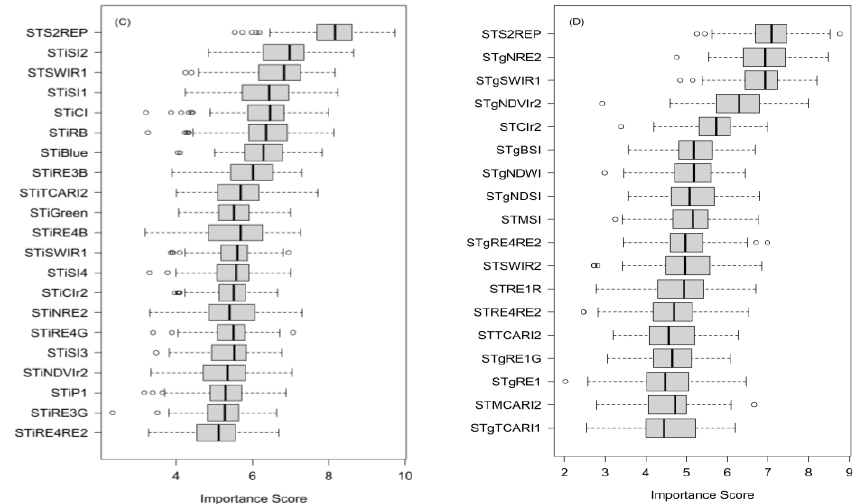
Figure 3. Importance score of Sentinel-2-based spectral indices identified as predictors in ( A ) Sentinel-2 model; ( B ) Brovey fused Sentinel-2-Landsat-8 model; ( C ) IHS fused Sentinel-2-Landsat-8 model; ( D ) GS fused Sentinel-2-Landsat-8 model.